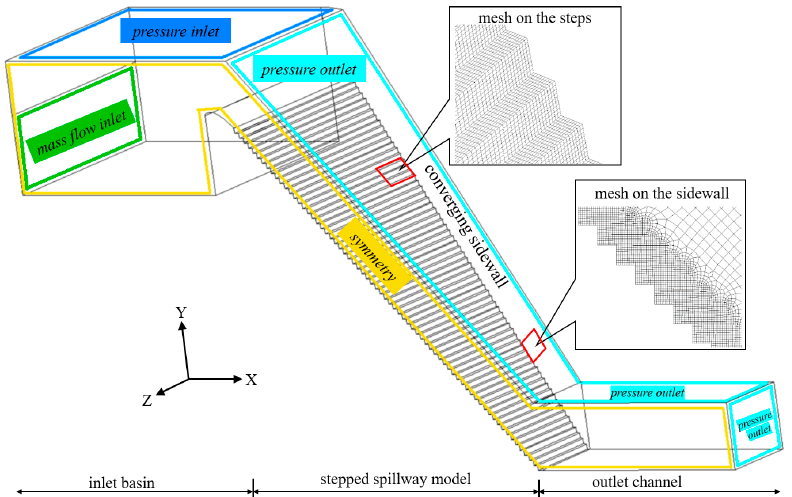
Figure 1. Computational domain, boundary conditions and mesh distribution of converging stepped spillway, inlet basin and outlet channel (with θ = 48.3°, B = 22.5 mm and Φ = 22.6° as an example). Table 1. Tested